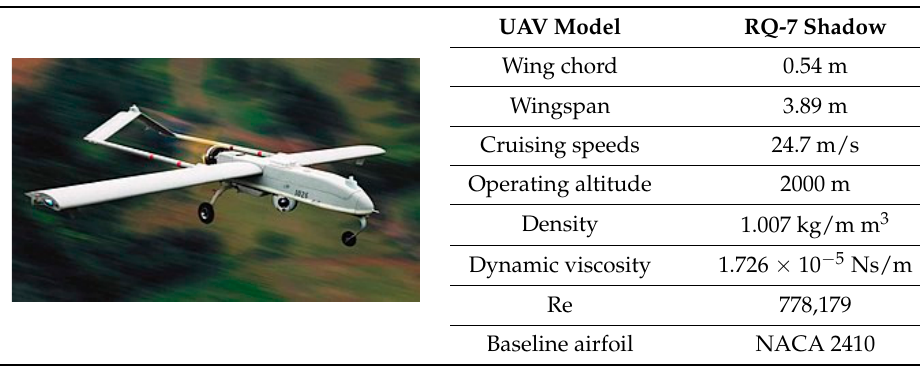
Table 1. UAV model and flight specification.